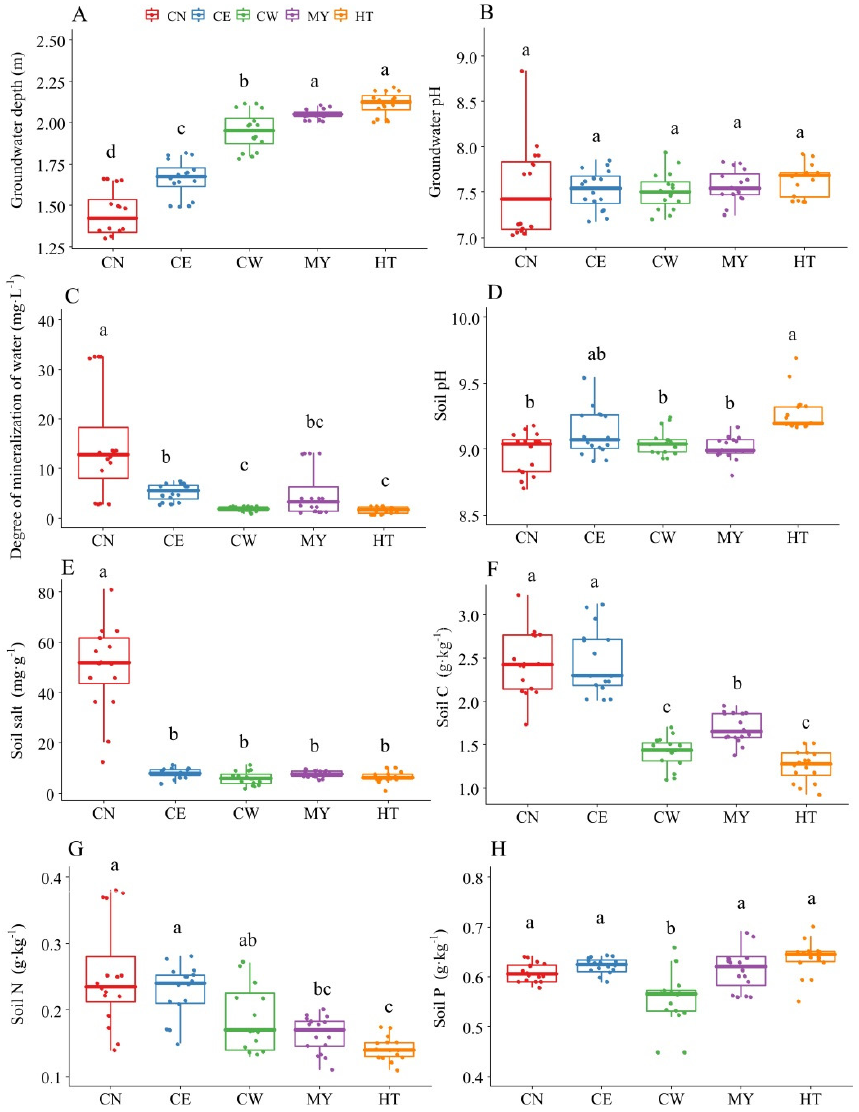
Figure 1. Changes in the environmental variables of the study sites. Vertical bars represent standard deviations, and the letters denote significant differences among different groundwater depths ( p < 0.05). CW, west of Cele county; MY, Moyu county; HT, Hetian county; CN, north of Cele county; CE, east of Cele county. ( A – H ) represent variations of depth, pH, and the mineralization degree of groundwater as well as pH, salt, C, N, and P concentrations of soil.